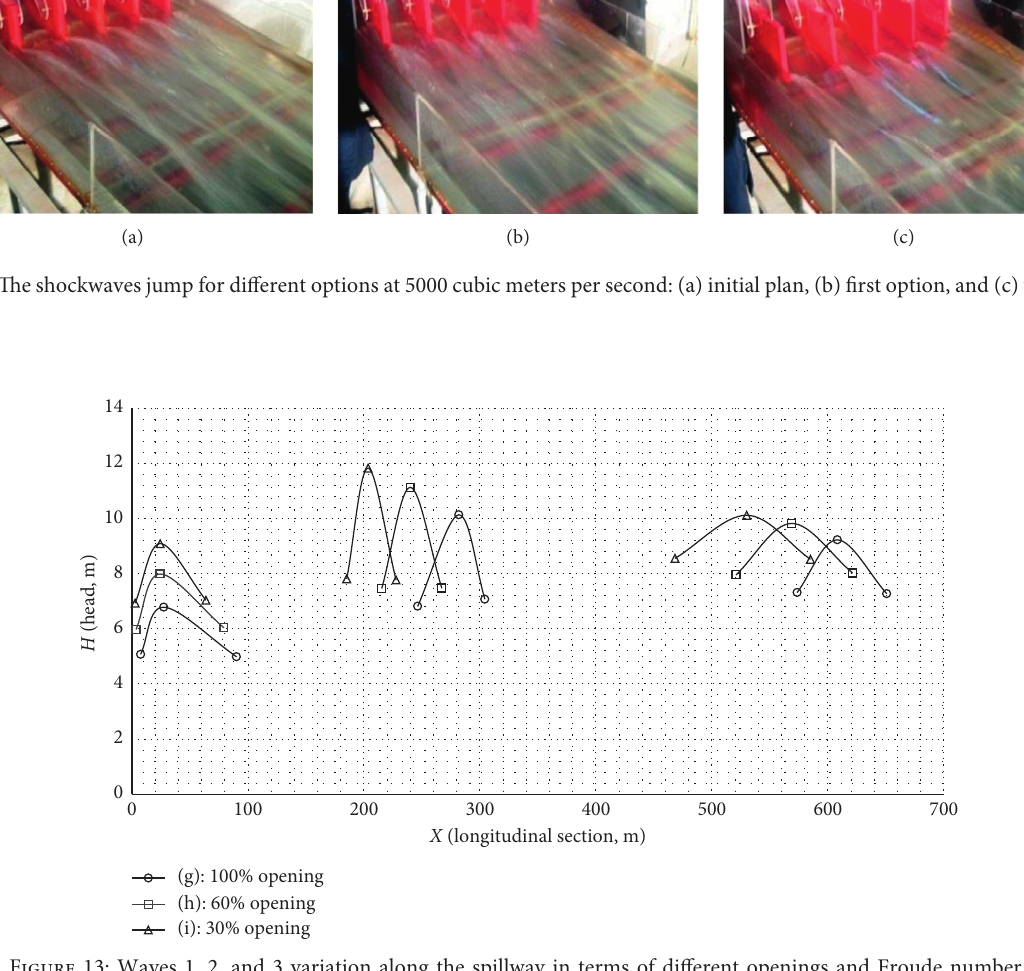
Figure 13: Waves 1, 2, and 3 variation along the spillway in terms of different openings and Froude number.